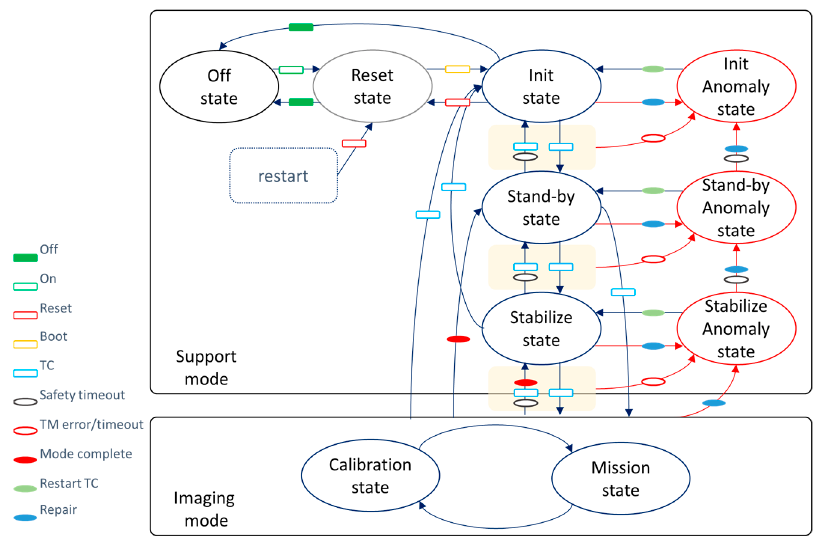
Figure 7. Mode transition diagram of the S-STEP SAR